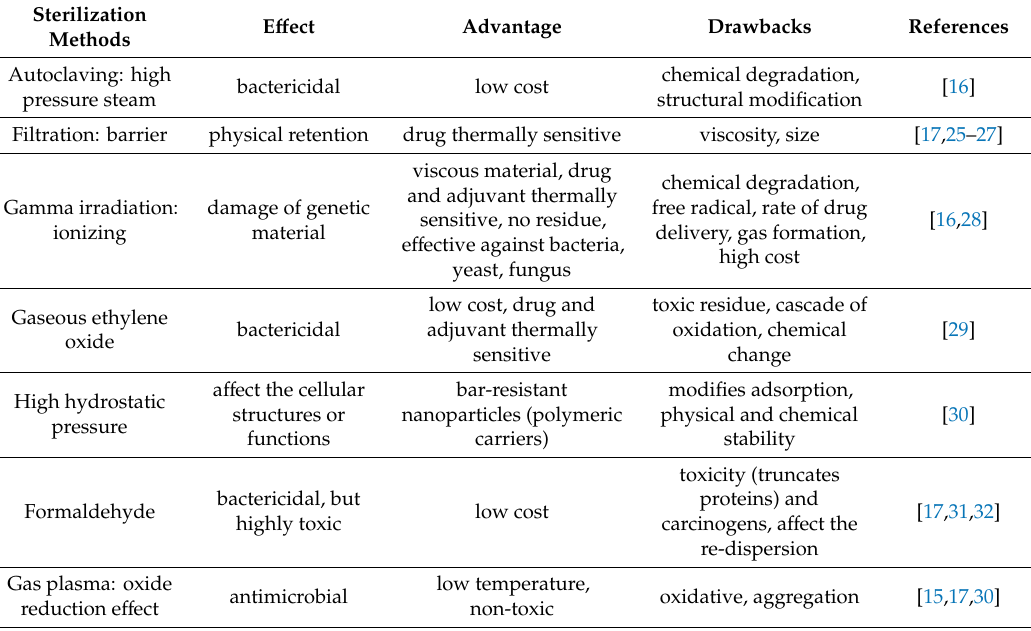
Table 1. Overview of ophthalmic nanopharmaceutical sterilization methods. Sterilization E ff ect Advantage Methods